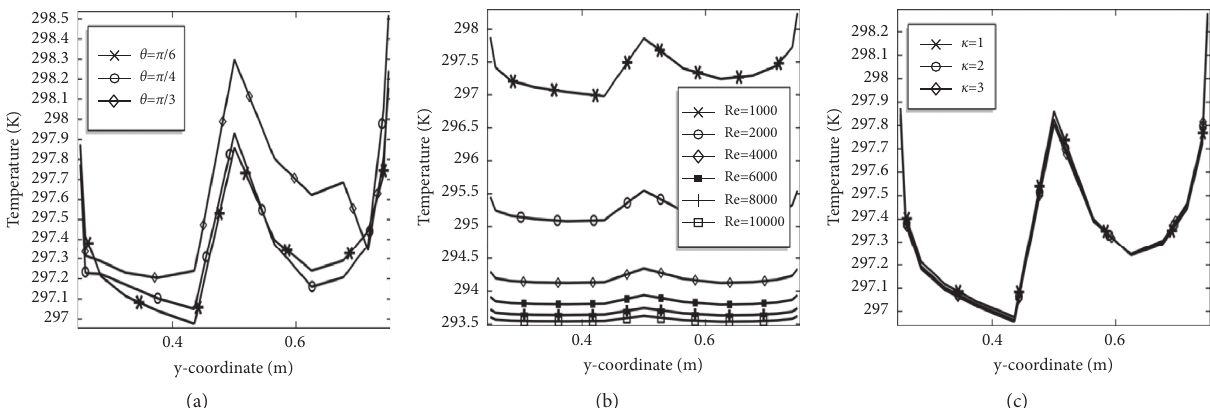
Figure 6: Temperature K on the front surface of the circular cylinder (a) for all angles by fixing Re � 1000 and κ � 1; (b) for all Re by fixing κ � 1 and θ � π /6; (c) for all κ by Re � 1000 and θ � π